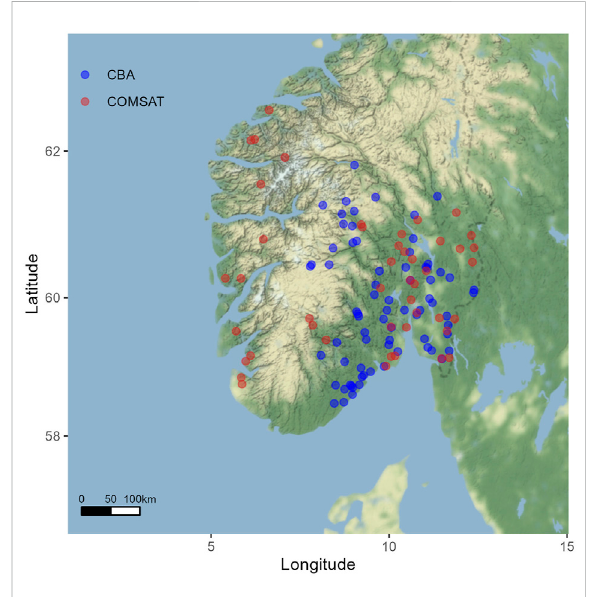
FIGURE 1 Lakes included in CBA (n = 73) and COMSAT (n = 46)